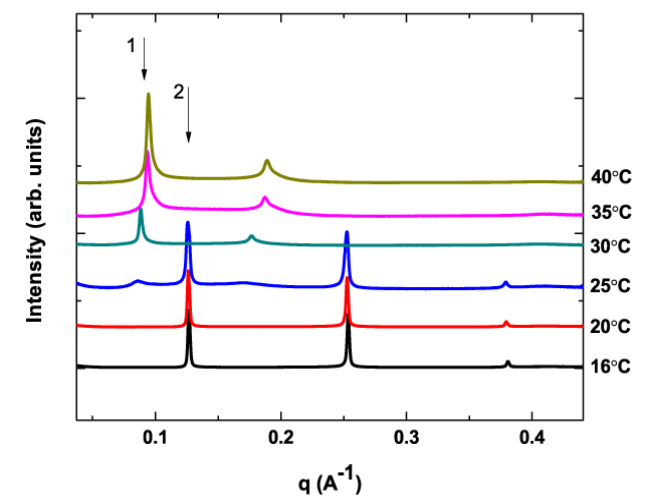
Figure 2. Transmission solution small angle X-ray scattering (SAXS) data for mixture of DPPC/DHA-PE at DHA-PE 0.1 mol%. At 25 °C, phase coexistence can be observed as two sets of Bragg peaks are present. The first order peaks for each phase are indicated by arrow 1 (fluid phase—L α ) and arrow 2 (gel phase—L β′